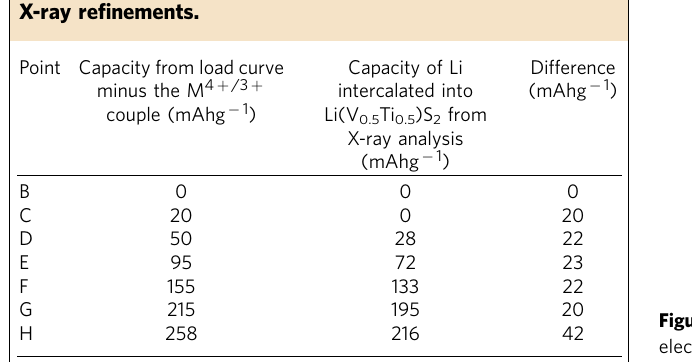
Letters correspond to the points on the 1st cycle in Fig. 3.